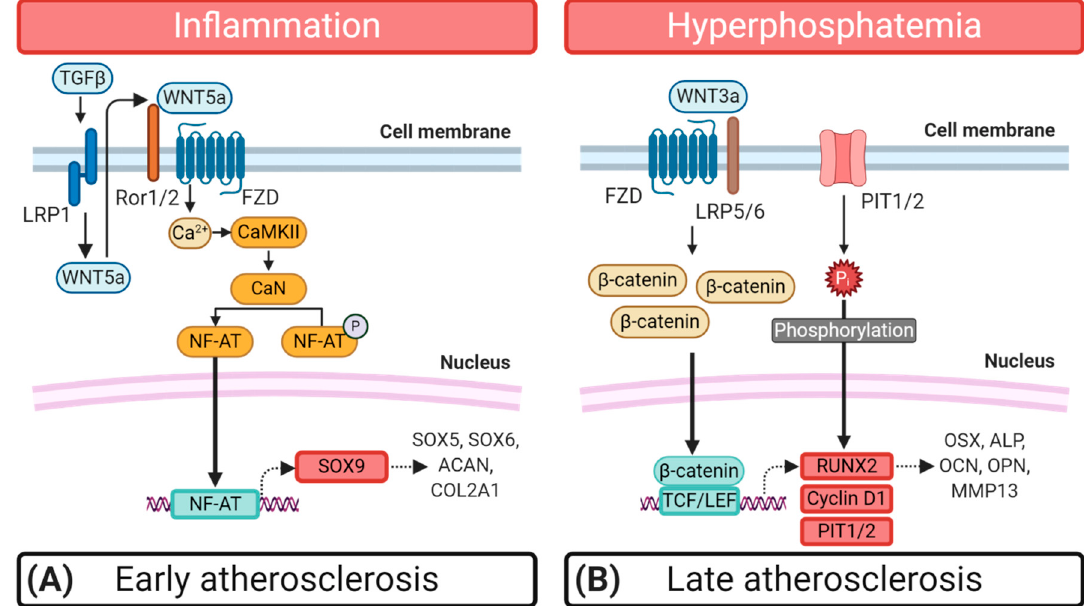
Figure 2. Schematic representation of the Wingless and Int-1 (WNT) signaling pathways and their role during the osteochondrogenic transition of synthetic vascular smooth muscle cells (VSMC). ( A ) Chronic inflammation stands at the beginning of early atherogenesis and initiates the β -catenin-independent WNT signal transmission, which sparks the osteochondrogenic di ff erentiation of VSMC. Transforming growth factor β (TGF β ) binds to the low-density lipoprotein receptor 1 (LRP1), leading to the expression of WNT5a through an unknown mechanism in VSMC. WNT5a, mainly originates from surrounding macrophages and binds to frizzled receptors (FZD) and receptor tyrosine kinase-like orphan receptors 1 or 2 (ROR1 / 2). This activation induces the WNT / Ca 2 + pathway involving Ca 2 + / calmodulin-dependent protein kinase II (CaMKII) and Calcineurin (CaN). Subsequently, CaN dephosphorylates the nuclear factor of activated T-cells (NF-AT), leading to the translocation of NF-AT to the nucleus where it initiates the transcription of the chondrogenic determinant SRY-box transcription factor 9 (SOX9), inducing the expression of extracellular matrix proteins like Aggrecan (ACAN), Collagen type II alpha (COL2A1), SOX5, and SOX6. ( B ) In late atherogenesis, conditions like hyperphosphatemia increase WNT / β -catenin signaling activity by inducing the expression of WNT / β -catenin ligands such as WNT3a. Binding of WNT3a to FZDs, co-activates lipoprotein receptor-related protein 5 or 6 (LRP5 / 6) inducing the recruitment of dishelved (DVL) protein to the receptor complex. Subsequently, DVL binds the β -catenin destruction complex, containing glycogen synthase kinase 3 β (GSK3 β ), axin, adenomatous polyposis coli (APC) and casein kinase-1 (CK-1). This leads to an accumulation of β -catenin in the cytoplasm, followed by its translocation to the nucleus where it forms a complex with T-cell factor / lymphoid enhancer factor (TCF / LEF) to induce transcription of the osteogenic determinant runt-related transcription factor 2 (RUNX2) and the PPAR γ inhibitor Cyclin D1. RUNX2 controls the transcription of osteogenic factors such as Osteocalcin (OCN), Osterix (OSX), Osteopontin (OPN), matrix metalloprotease 13 (MMP13), and alkaline phosphatase (ALP).